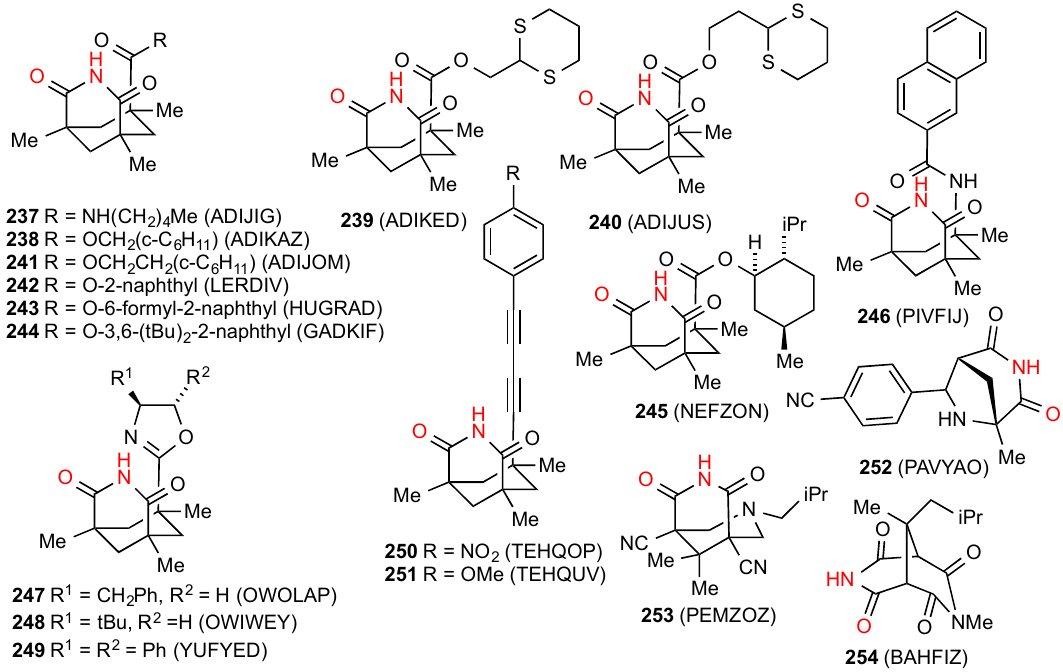
Figure 72. Bridged six-membered ring imides with pattern A dimer structures.